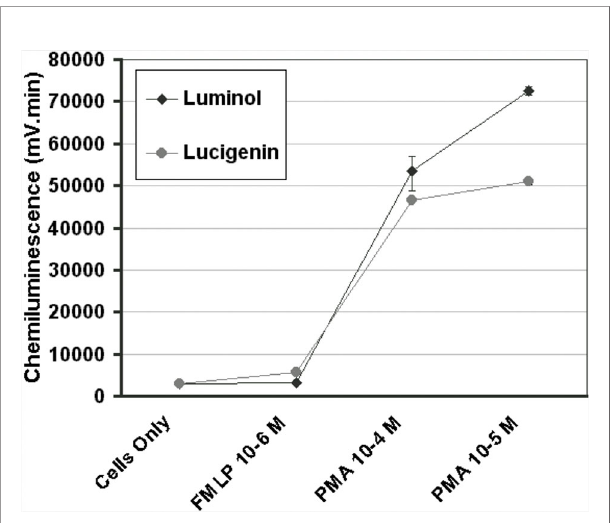
FIGURE 1 | Concentration curves for PMA and FMLP in the luminescence system, as indicated by the total chemiluminescence response of